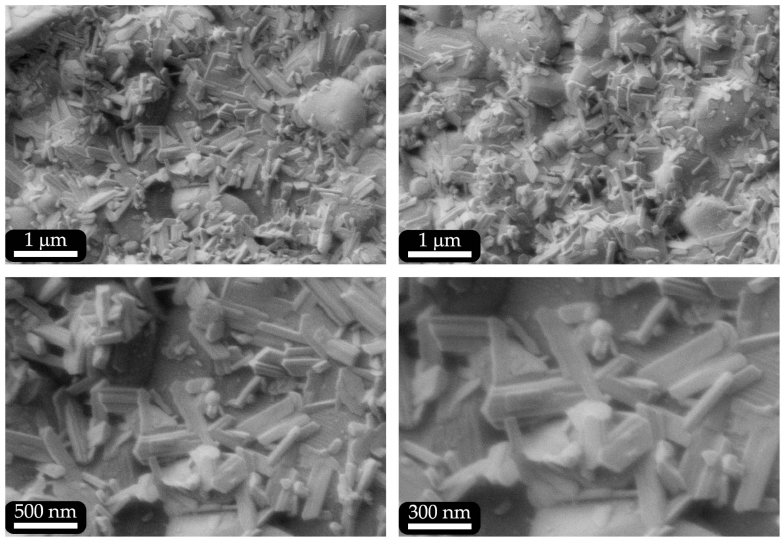
Figure 5. Microstructure of the V 2 O 5 film printed on the PAP surface (according to SEM data).